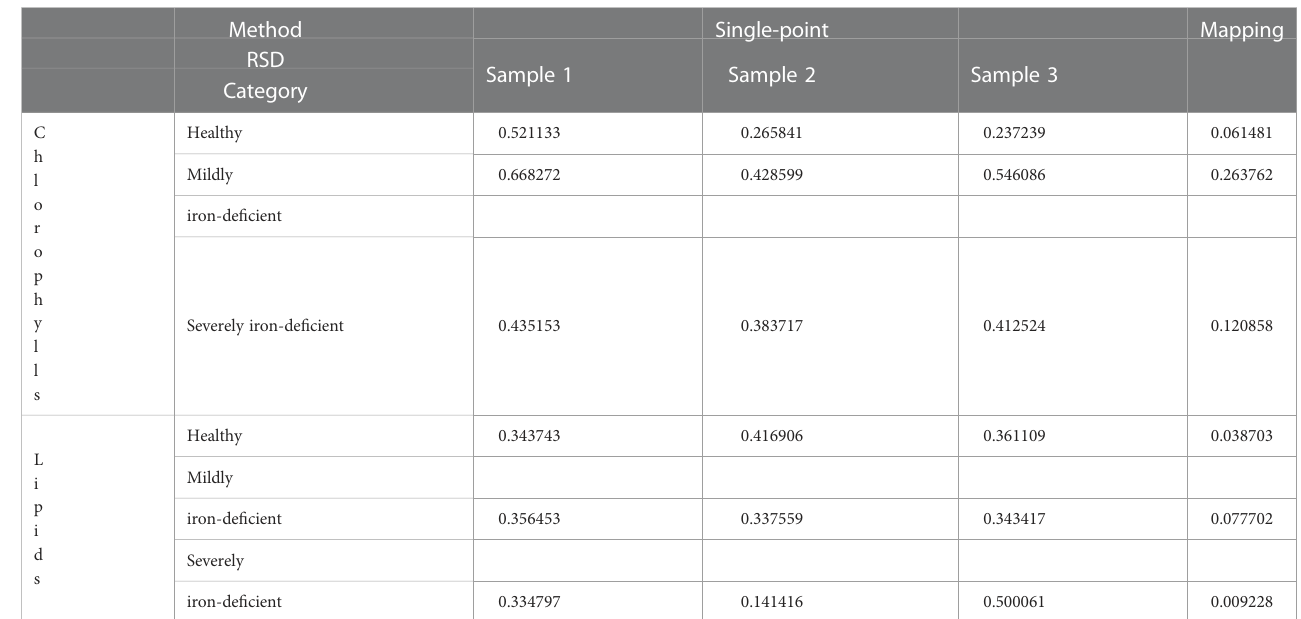
TABLE 2 The RSD calculated in the single-point and mapping acquisition